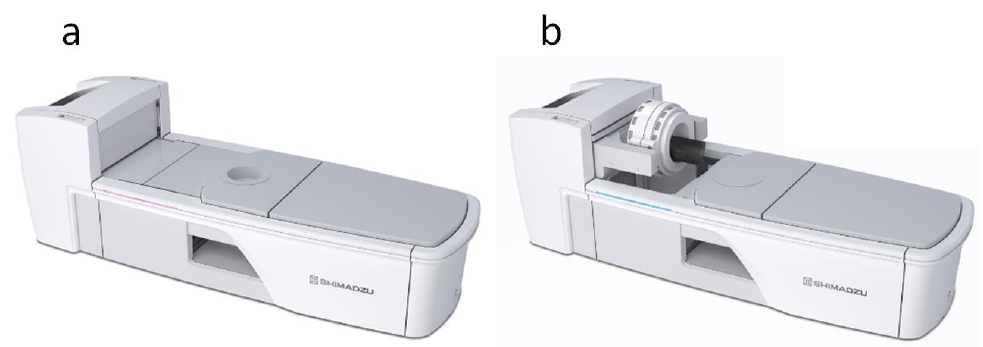
Figure 1. The new, organ-specific, positron emission tomography (PET) system (BresTome™) in the positions for the scanning of the breast ( a ) and the head ( b ).